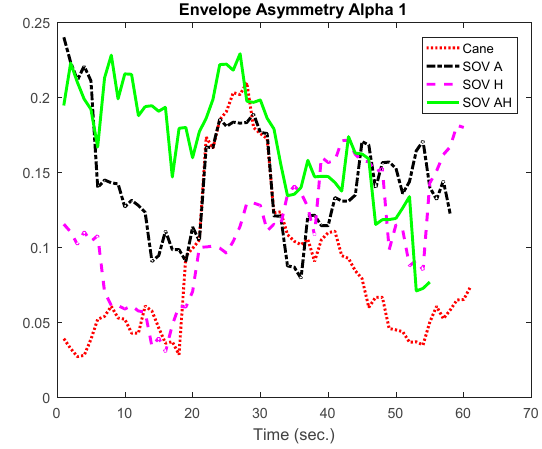
Figure 22. The average of the alpha1 asymmetry for all the users.